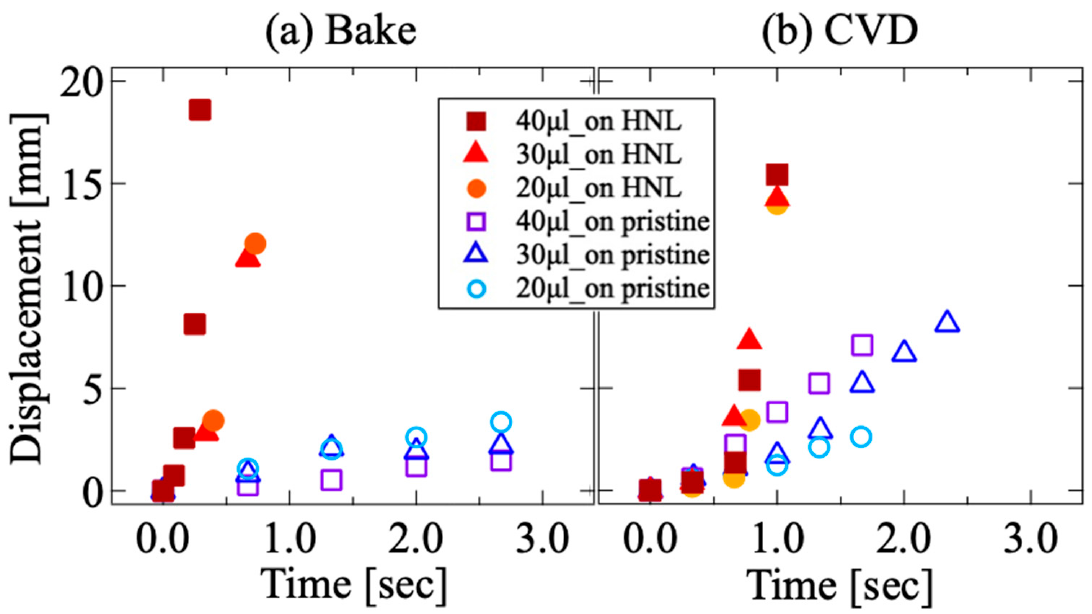
Figure 3. The displacement of water droplets on samples PDMS-coated ( a ) by baking and ( b ) by CVD. The HNL-substrate samples exhibited significantly large sliding velocity for both coating methods.